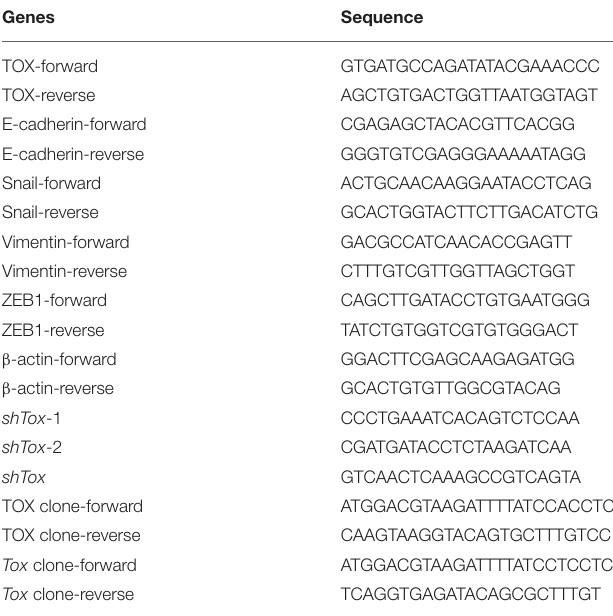
TABLE 5 | Primers used in the study. Genes